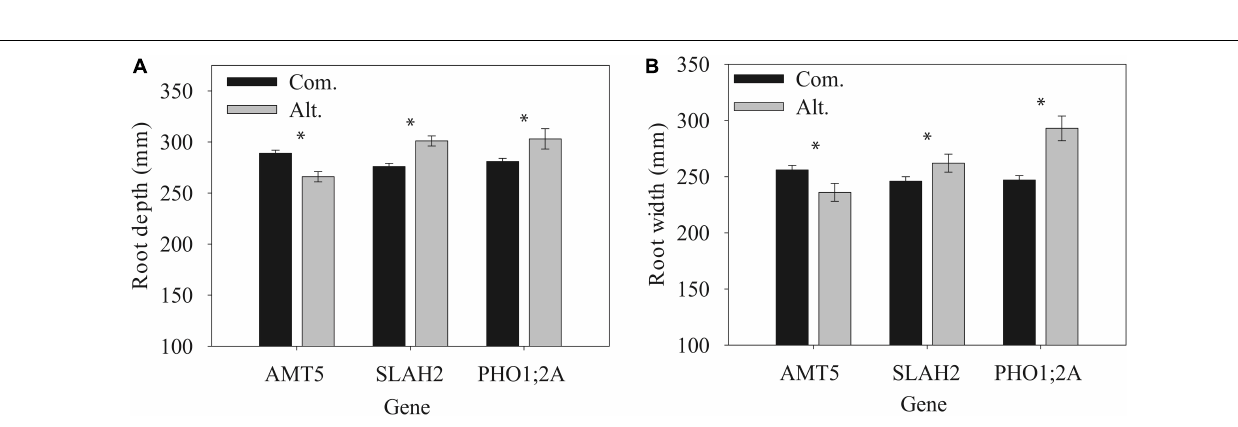
Frontiers in Plant Science |